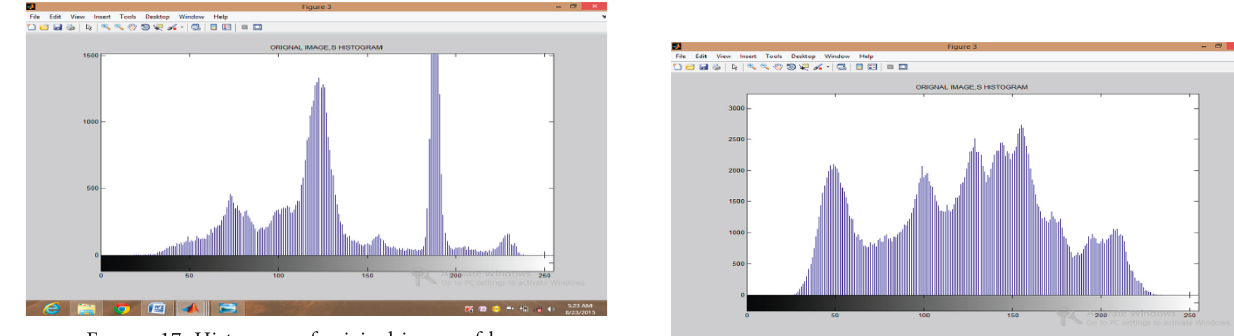
Figure 17: Histogram of original image of house.